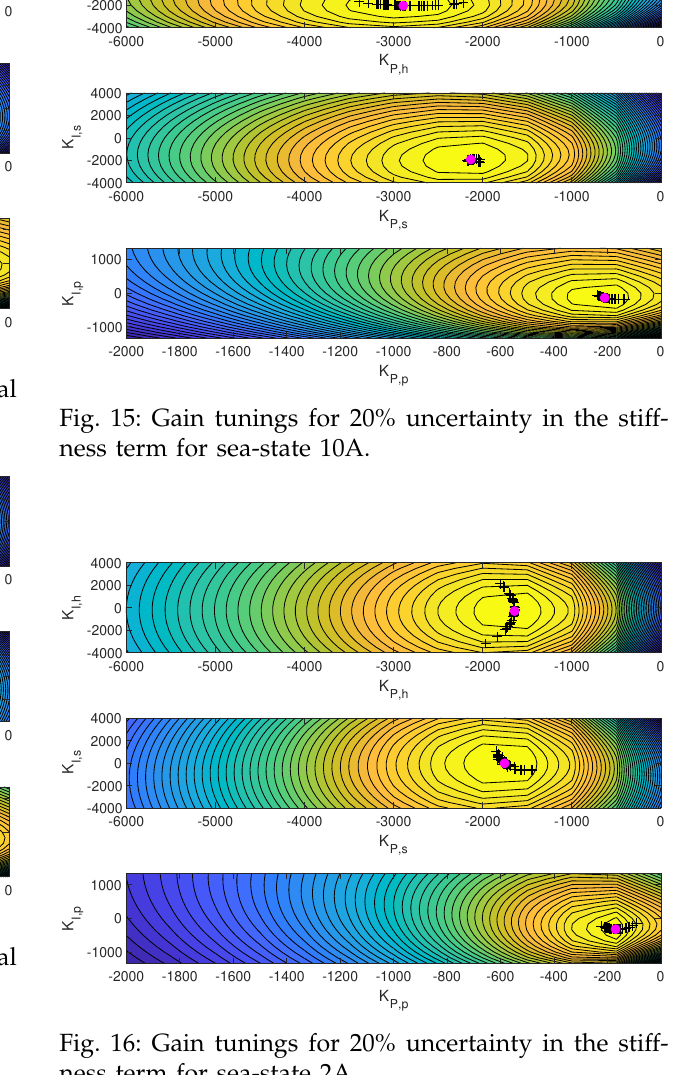
Fig. 16: Gain tunings for 20% uncertainty in the stiff- ness term for sea-state 2A.